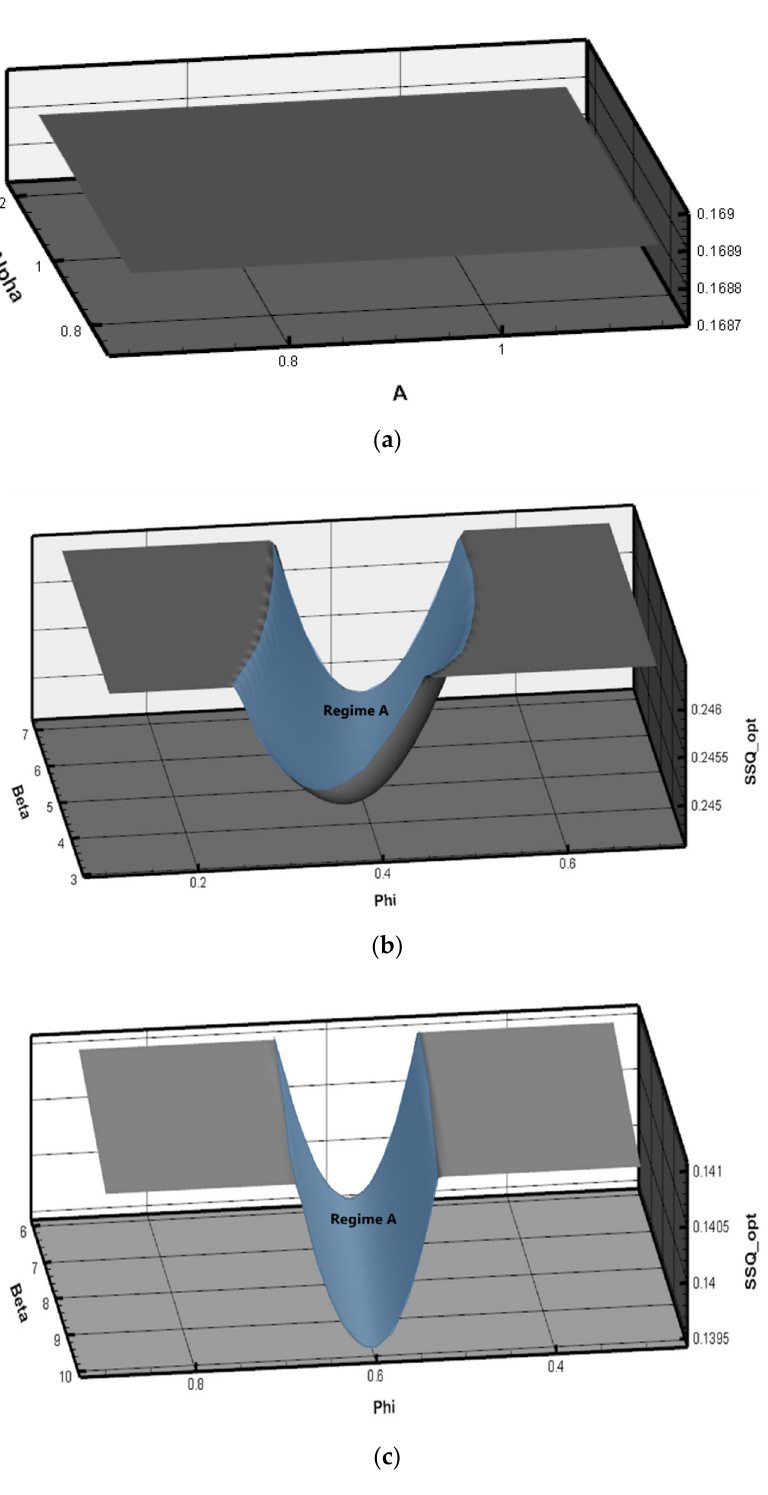
Figure 7. SSQ (cid:3042)(cid:3043)(cid:3047) distribution in the back-calculation parameter space: ( a ) ( 𝐴 , 𝛼 ), uranium (dry); ( b ) ( 𝜑 , 𝛽 ), molybdenum Figure 7. SSQ opt distribution in the back-calculation parameter space: ( a ) ( A , α ), uranium (dry); ( b ) ( ϕ , (dry); and ( c ) ( 𝜑 , 𝛽 ) molybdenum (wet). β ), molybdenum (dry); and ( c ) ( ϕ , β ) molybdenum